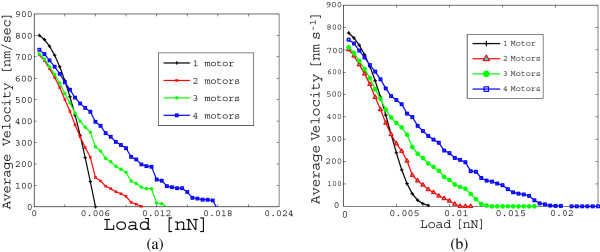
Average velocity of the cargo as a function of the load in the case of ensemble of motors of different sizes (from one motor to four motors) in a case where thermal fluctuations are neglected (a) and where they are approximated with a truncated Gaussian (b). These curves, obtained via our exact method, reproduce the Monte Carlo simulation results in [7] for the same set of parameters.